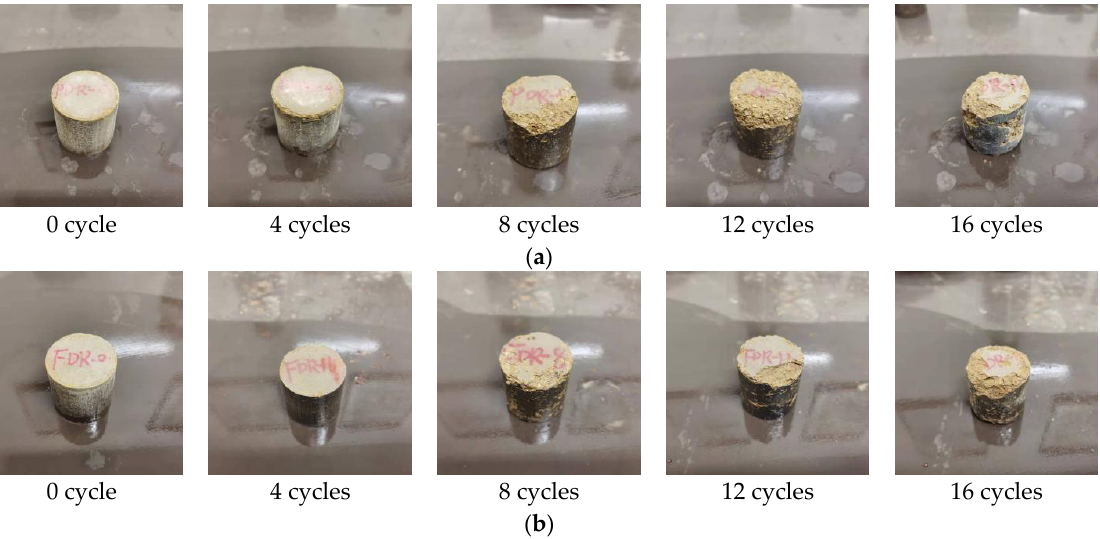
Figure 7. ( a ) Damage of ordinary-cemented soil subjected to freeze – thaw cycles (cured for 28 d). ( b ) Damage of composite-cemented soil subjected to freeze – thaw cycles (cured for 28 d). As shown in Figure 6, the edges of the ordinary and composite-cemented soil sam- ples are both chipped and lost, and their outer walls are eroded after 8 wetting – drying cycles; after 16 wetting – drying cycles, pits and slots spread all over the samples. However, the comparison indicates that the ordinary-cemented soil has a larger mass loss after wet- ting – drying cycles, while the composite-cemented soil has a higher resistance to wetting – drying cycles than the ordinary one. It can be seen from Figure 7 that damage, including chipped and lost edges, eroded outer walls, and widespread pits and slots, is also ob- served on ordinary and composite-cemented soil after freeze – thaw cycles. Similarly, the ordinary-cemented soil also shows a larger mass loss after freeze – thaw cycles, which in- dicates that the composite-cemented soil is of higher resistance to freeze – thaw cycles than the ordinary one.